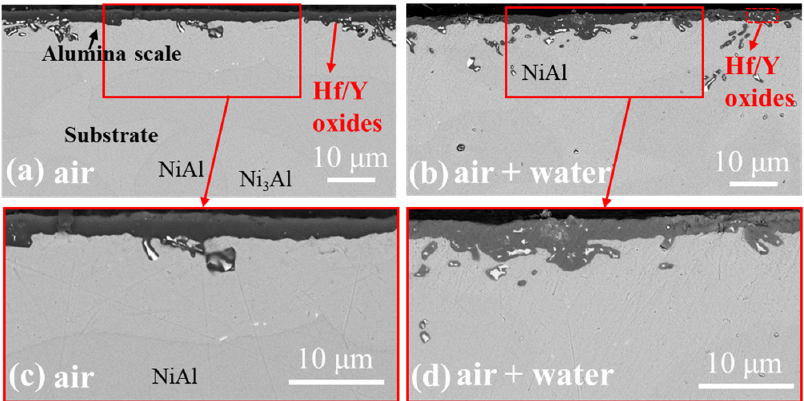
Figure 3. Cross-section SEM/BSE morphology of the oxide scale on NiCrAlYHf alloy after oxidation at 1100 ◦ C for 100 h in air ( a , c ) and air–water vapor ( b , d ).